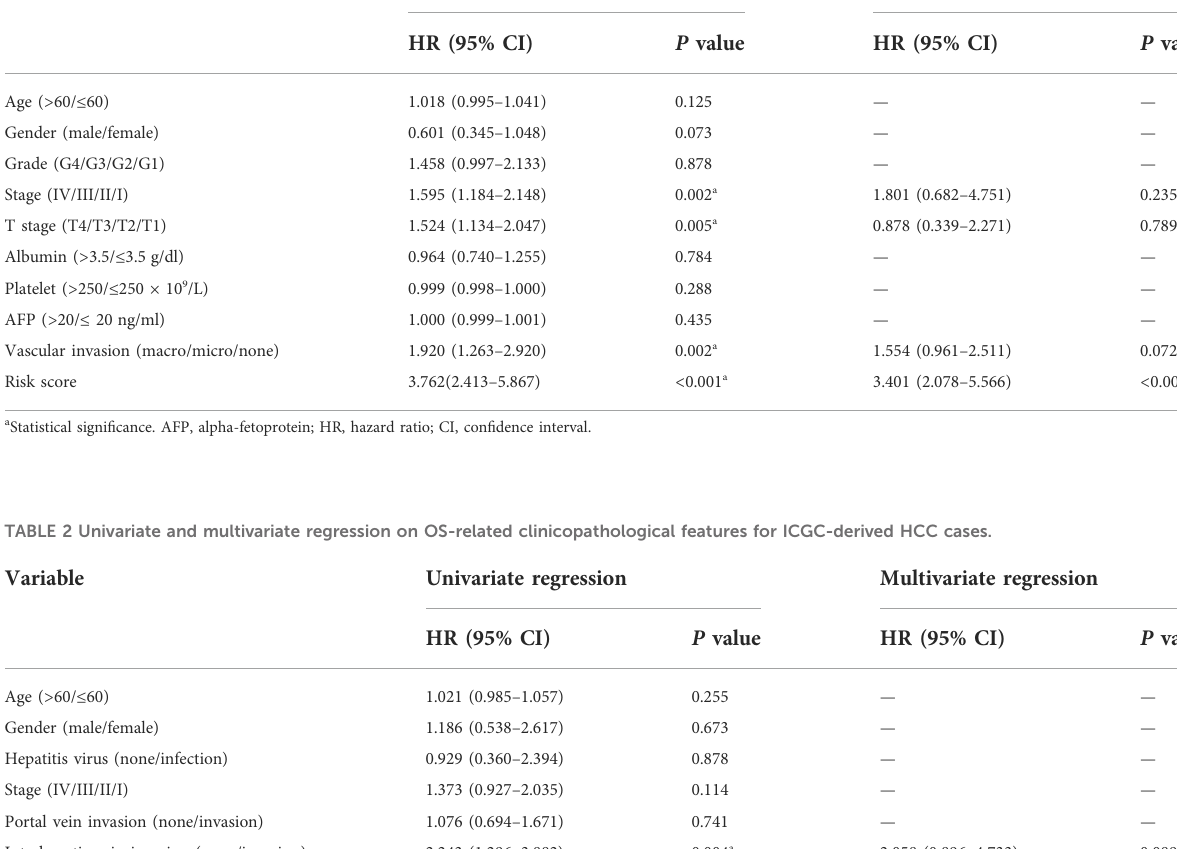
Intrahepatic vein invasion